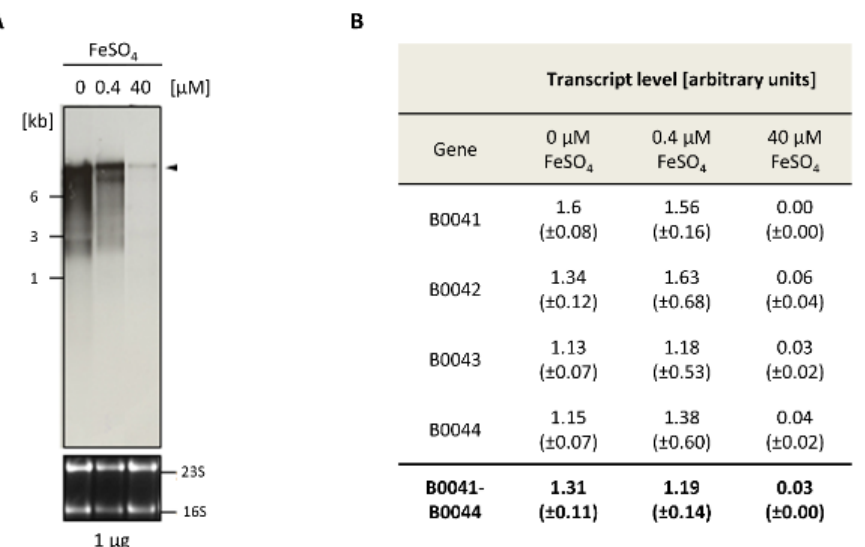
Figure 2. Differential expression of the iuc genes in the absence of iron and at two Fe 3+ concentrations. ( A ) Northern blot analysis. The FeSO 4 concentrations are indicated at the top. The upper part shows the signals of the Northern blot with a probe against HVO_B0044 , while the lower part shows the stained RNA gel with the 16S and 23S ribosomal RNA (rRNA) bands. ( B ) Summary of the quantification of the messenger RNA (mRNA) levels with four probes that were specific for the four iuc genes. The Northern blots were scanned, and the signals were quantified with the software ImageJ (imageJ.nih.gov). Rectangular frames were used for signal quantification, and frames of the same size were used for background subtraction. Average values for three biological replicates and their standard deviations are shown. At the bottom, the averages for the four probes are shown.